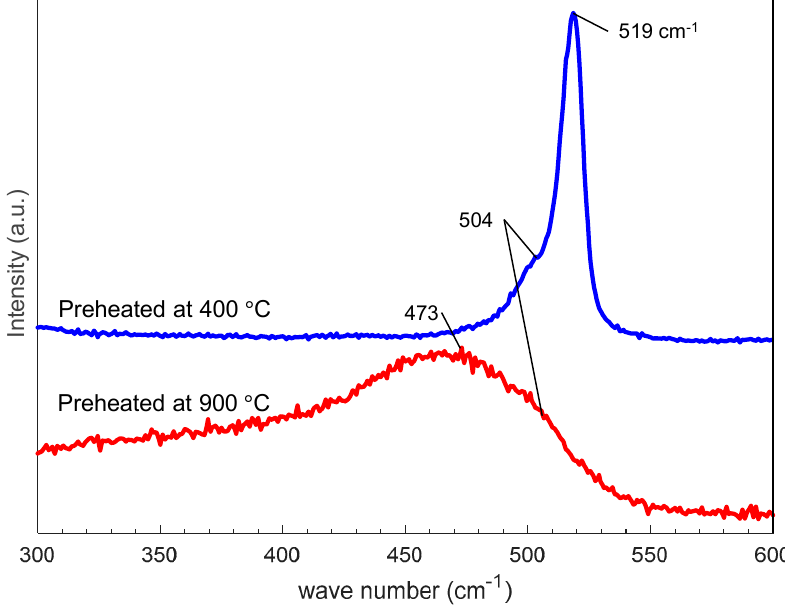
Figure 11. Raman spectra of nanofibers generated from silicon sludge preheated at different temperatures.